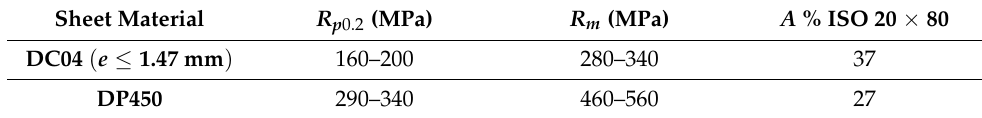
Table 5. Steels mechanical